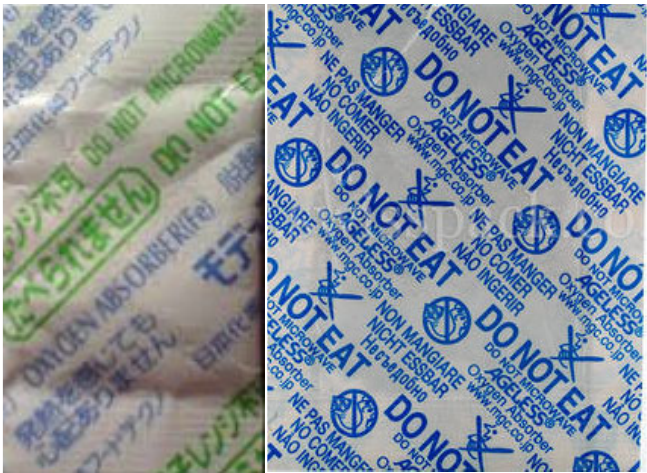
Figure 2. Examples of oxygen absorbers.